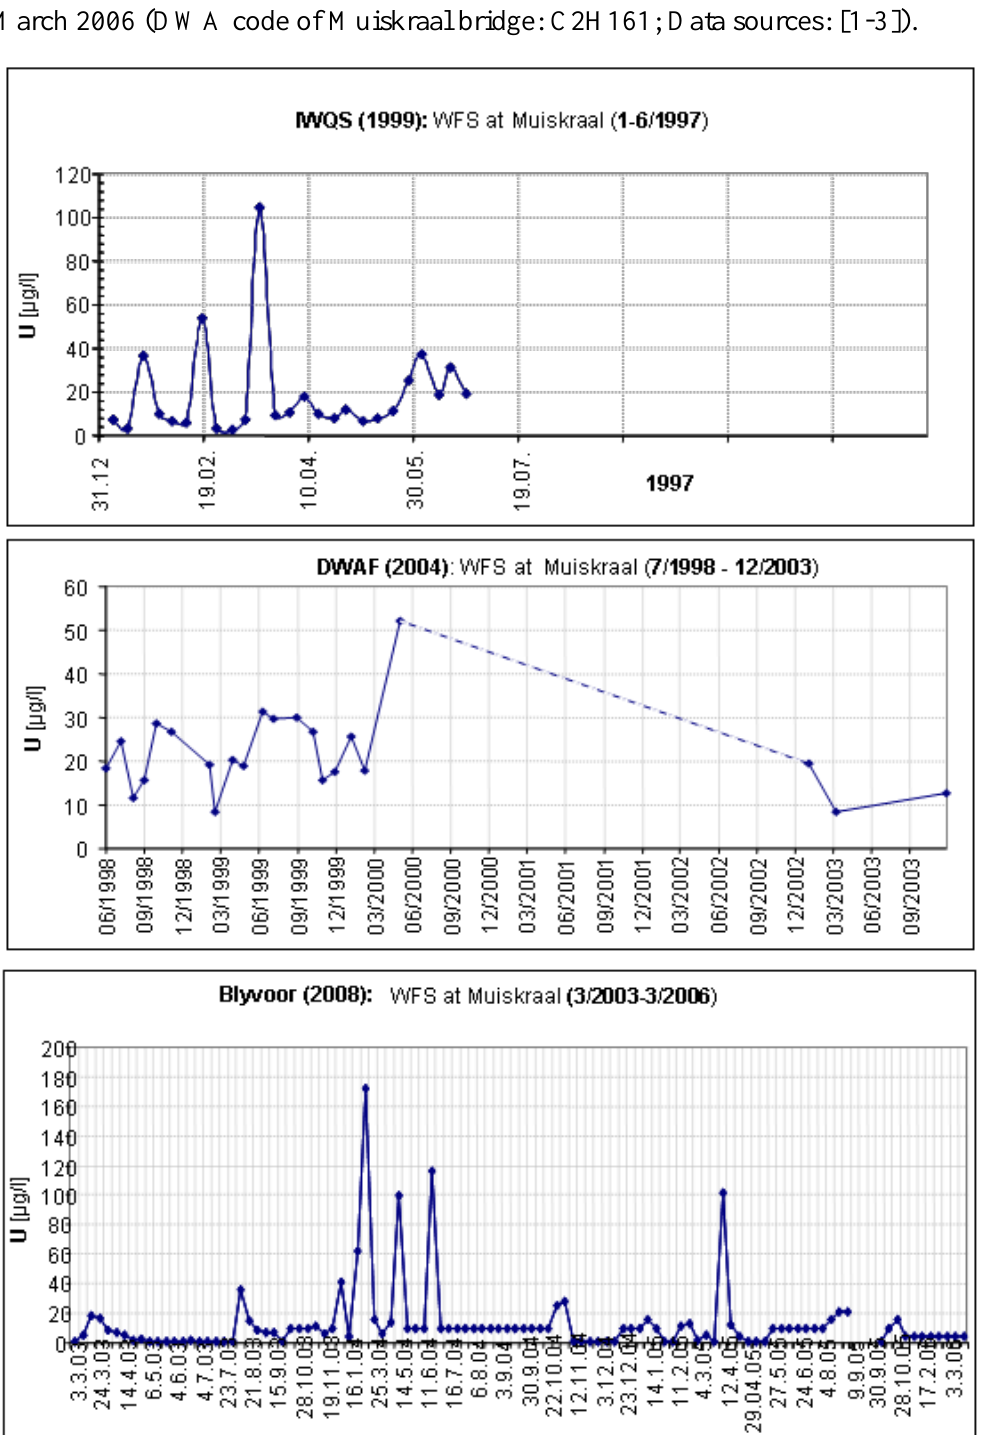
Figure 2. Dynamic of U concentration of exfiltrating groundwater (baseflow feeding the lower WFS at Muiskraal bridge) as found in three different studies between January 1997 and March 2006 (DWA code of Muiskraal bridge: C2H161; Data sources: